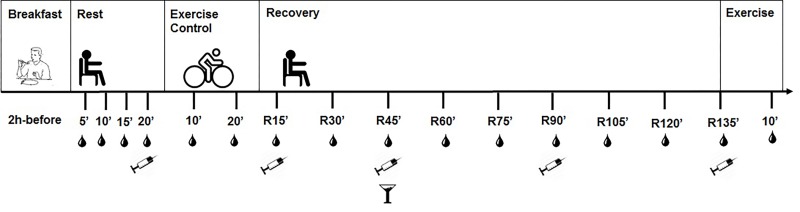
Summary of experimental design, entailing breakfast, a rest period, a 20-min submaximal exercises at constant workload (SE) or control session (CS) (both performed by all (9) participants), a recovery period, and a 10-min bout of moderate exercise (performed by 8 participants). Symbols: Drop: capillary blood collection for determination of glycemia. Syringe: venous blood collection for determination of insulin levels. Cup: administration of dextrose solution.